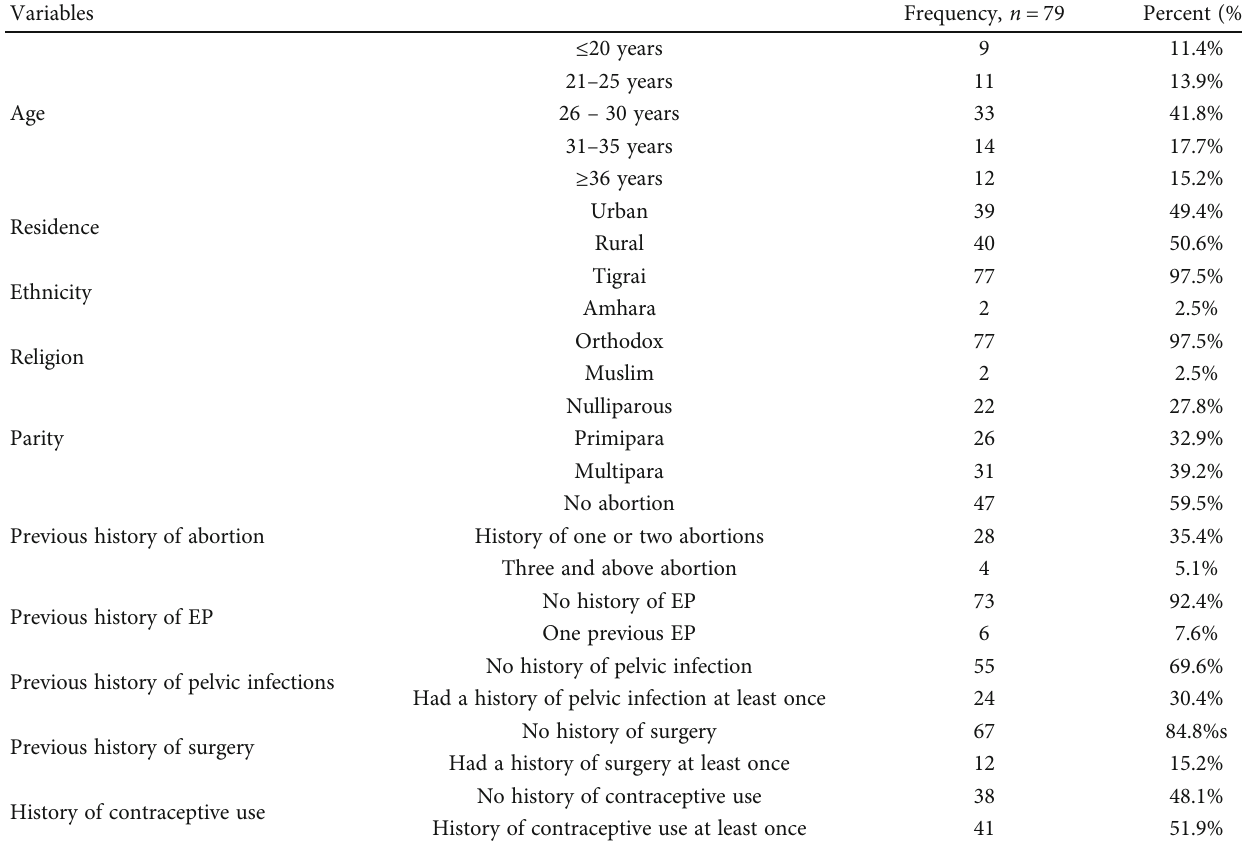
Table 1: Sociodemographic and gynecologic characteristic distribution of women admitted with EP in Aksum (AKU CHS CSH and Saint Marries General Hospital) in Tigray, North